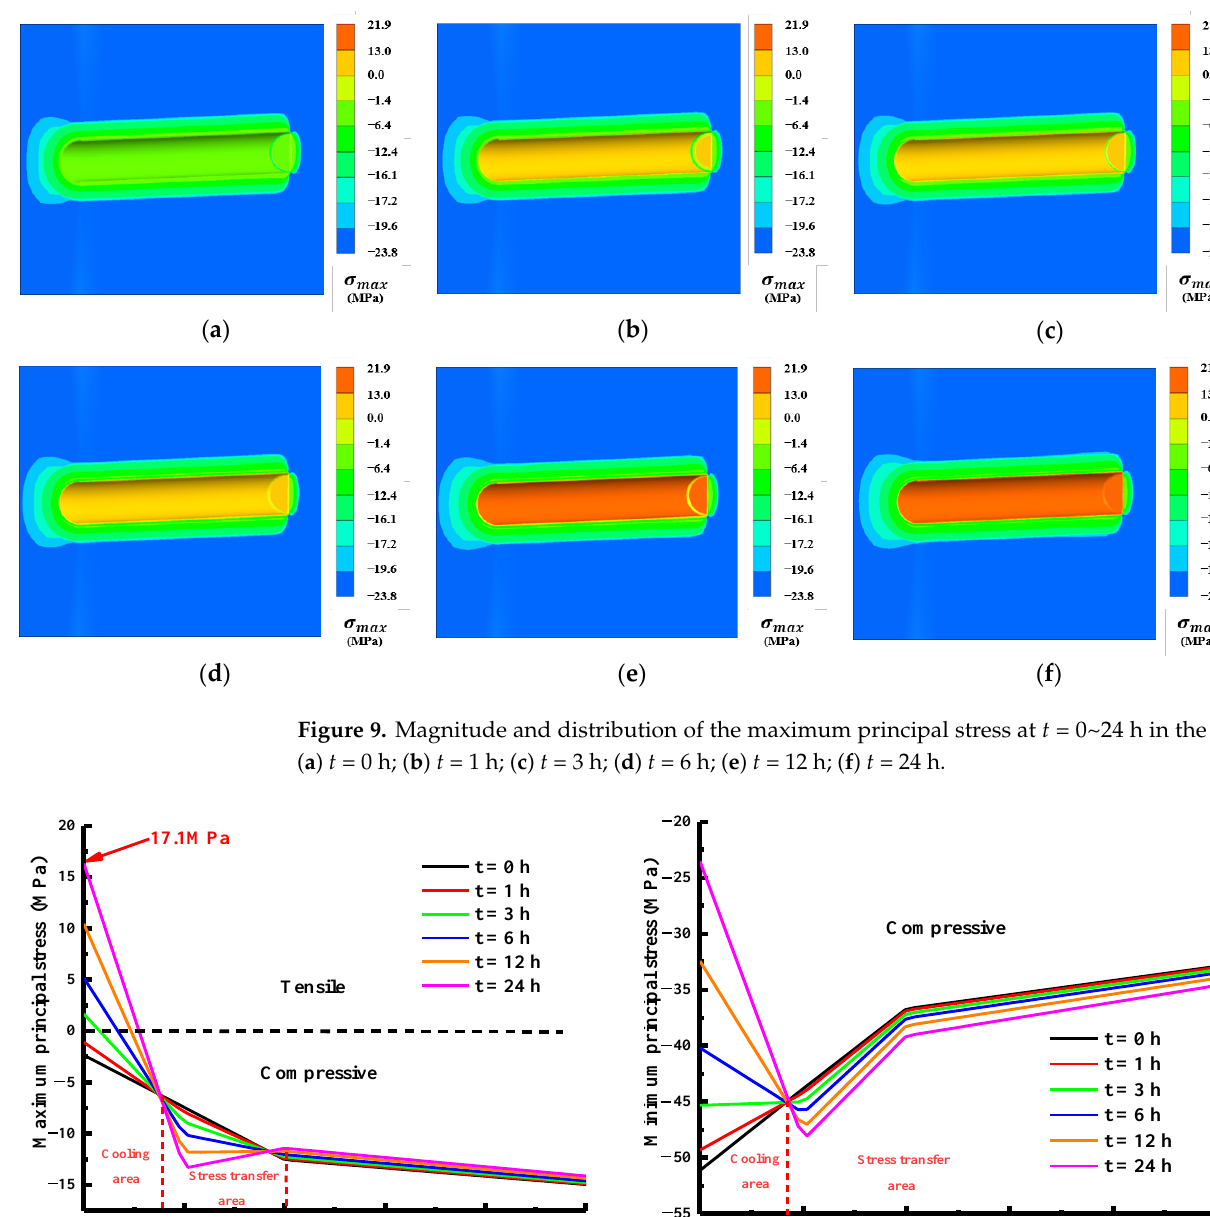
Figure 8. Magnitude and distribution of the minimum principal stress at t = 0~24 h in the tunnel. Figure 9. Magnitude and distribution of the maximum principal stress at t = 0~24 h in the tunnel. ( a ) t = 0 h; ( b ) t = 1 h; ( c ) t = 3 h; ( d ) t = 6 h; ( e ) t = 12 h; ( f ) t = 24 h.